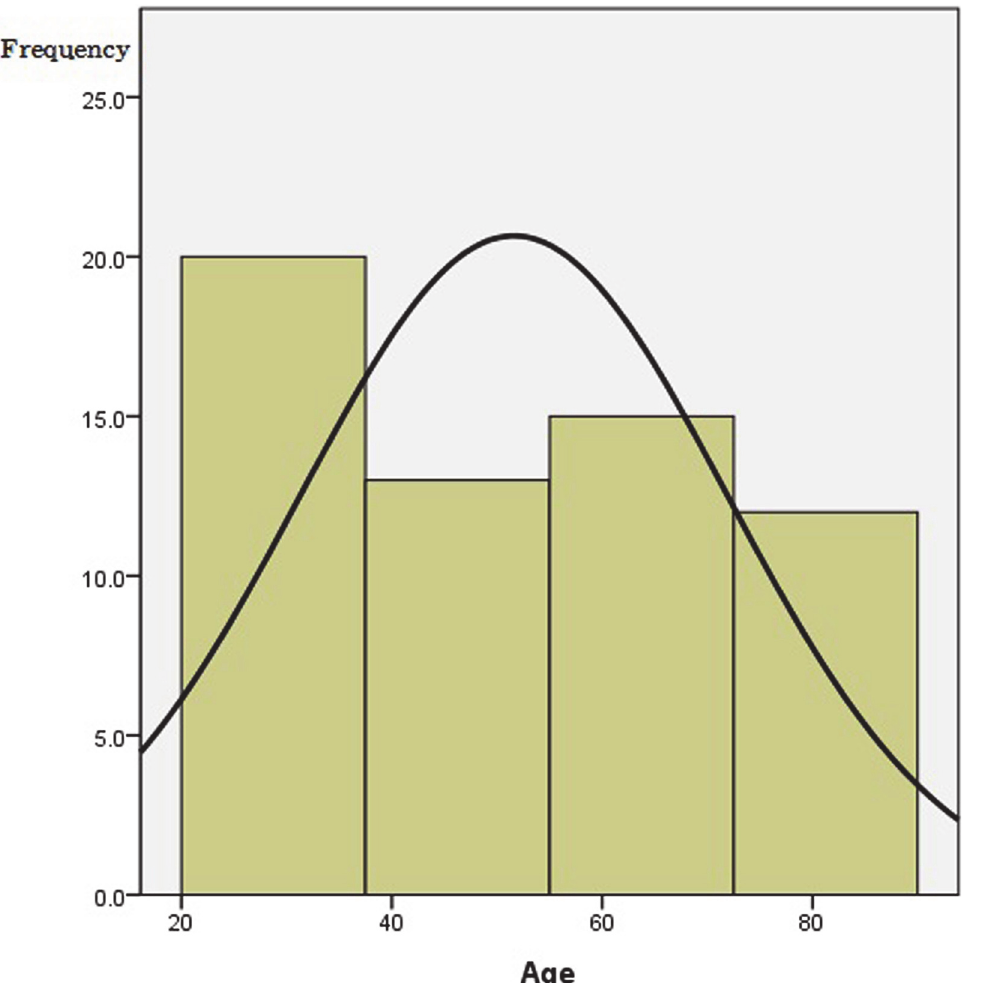
Fig 1. Distribution of